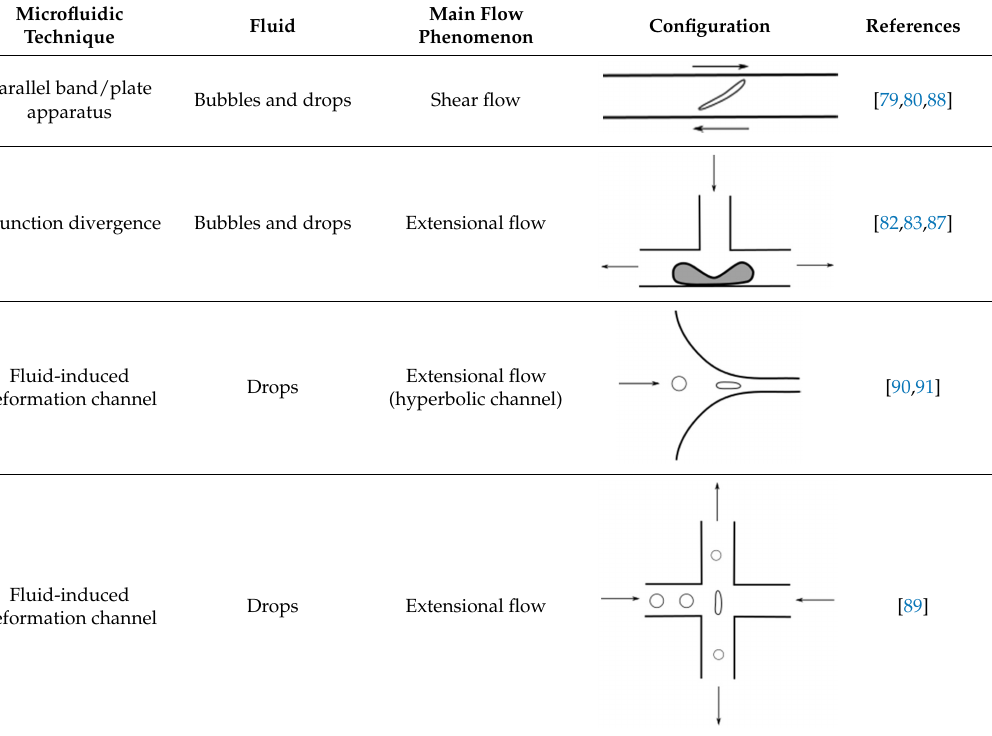
Table 3. Comparison of several deformability studies performed in microfluidic devices for bubbles and